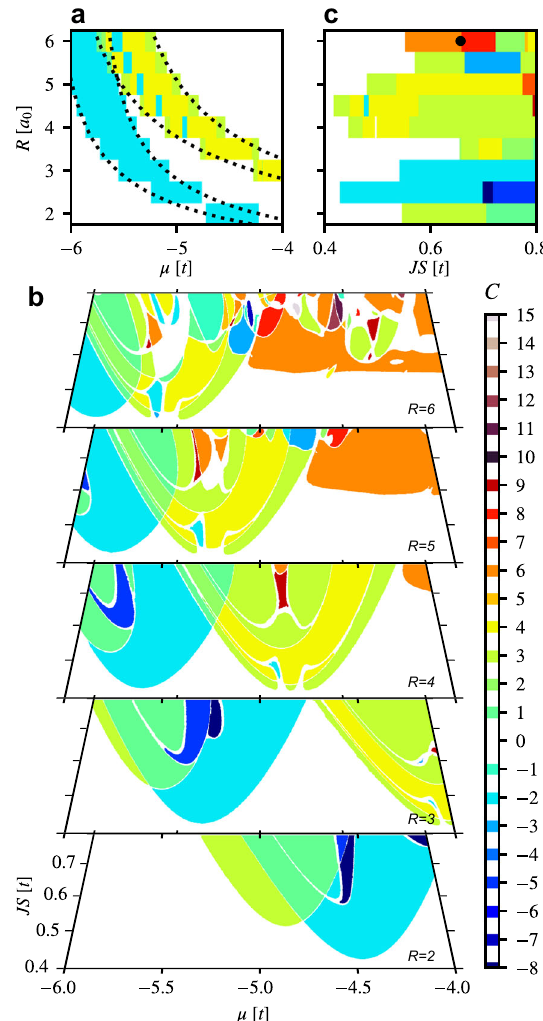
Fig. 2 Topological phase diagrams of a skyrmion MSH system. Topological phase diagrams representing the Chern number, C , in the a ( μ , R ) plane for JS = 0.5t, b ( μ , JS) planes for various skyrmion radii R , and c the (JS, R ) plane for μ = − 5 t and Δ = 0.4 t . Dotted lines in a represent phase transition lines described by μ = A i + B i / R 2 with constants A i , B i